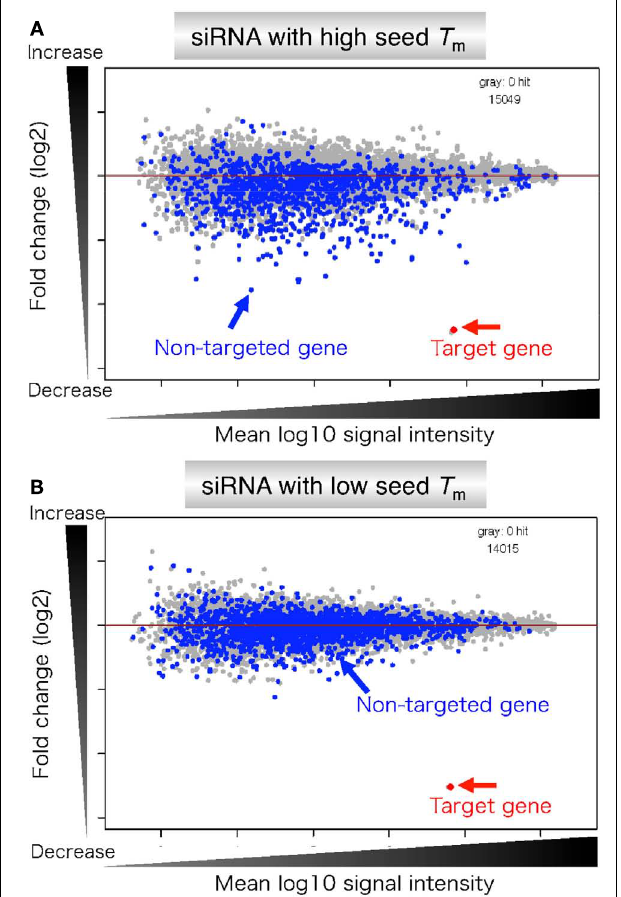
FIGURE 8 | Microarray profiles of transcripts downregulated by transfection of siRNA with high or low stability in the seed-target duplex. (A) siRNA with high seed T m is capable of forming stable seed duplexes with the 3 (cid:2) UTR counterpart of target mRNA. (B) siRNA with low seed T m is capable of forming unstable seed duplexes with the 3 (cid:2) UTR counterpart of target mRNA. Microarray-based expression profiles were examined 24h after transfection. Gene expression changes are shown by log2 of fold change ratio (ordinate) relative to mock transfection.The abscissa represents transcript signal intensity (log10). Blue and gray dots represent transcripts complementary to the seed and those with no seed complementarity, respectively.Target genes are colored red and indicated by arrows.Their expression levels were similarly reduced.The number of genes examined is shown on the upper right edge of each